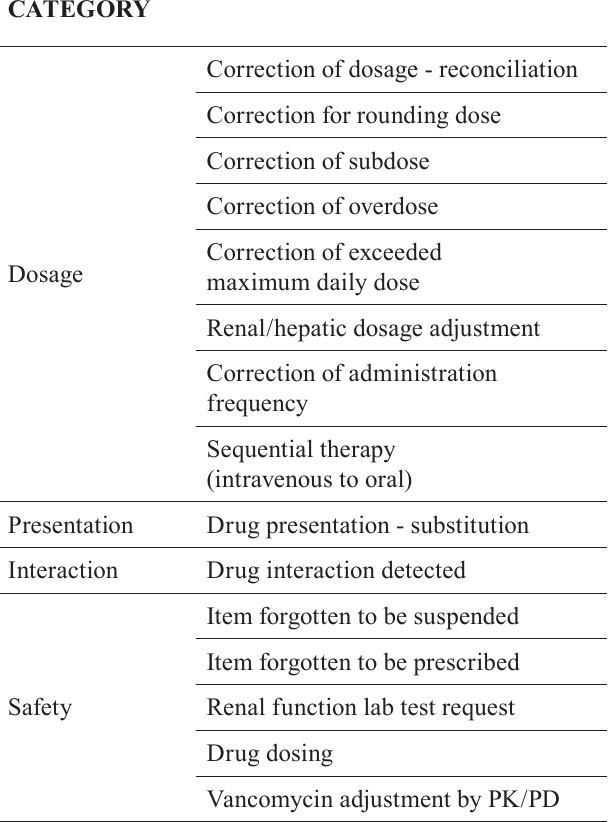
CHART I – C lassification of pharmaceutical interventions that have a direct economic